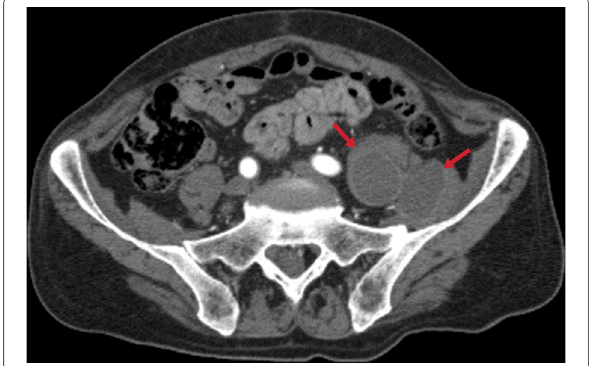
Fig. 55 A contrast-enhanced CT image of a 69-year-old male demonstrates the left iliopsoas abscess